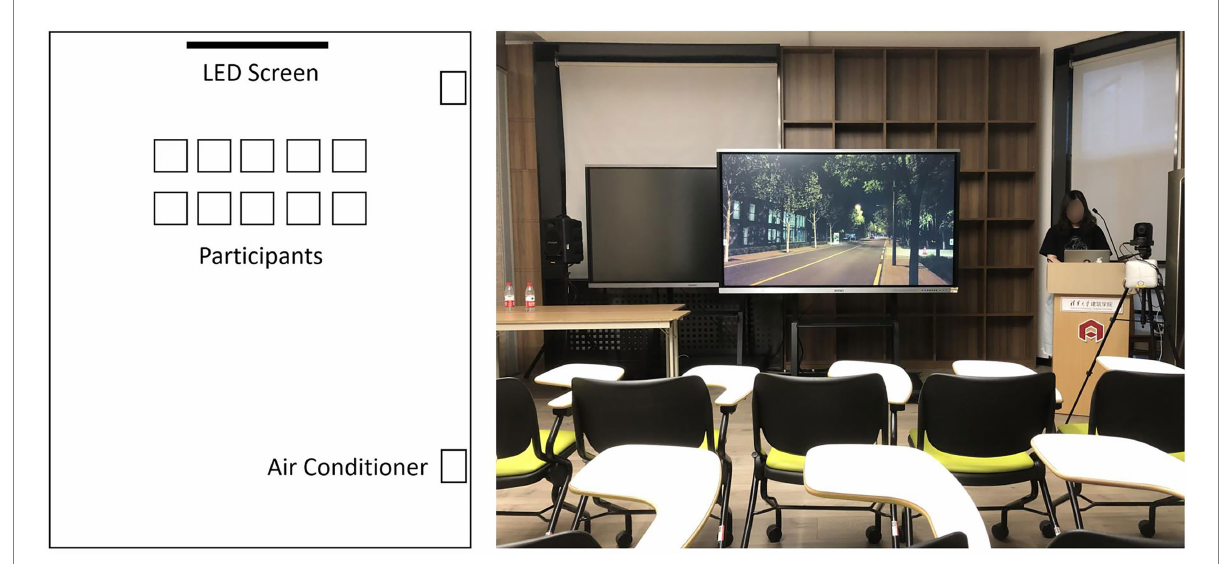
FIGURE 1 Experimental scene of street lighting evaluation (indoor lighting turned off during the